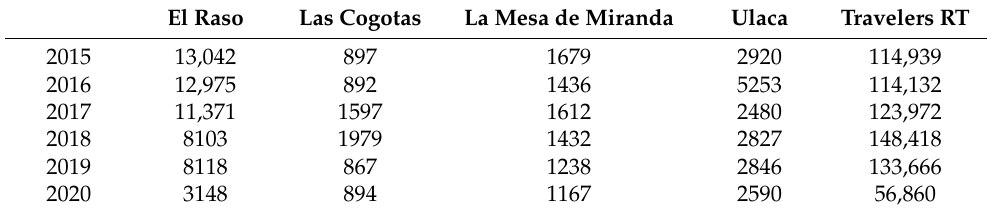
Table 1. Information about the visitors of the oppida , source: Territorial Service of Culture of Á vila. Traveler data, source: Rural Tourism (RT) Accommodation Survey. INE (National Statistical Institute of Spain) 2015–2020.